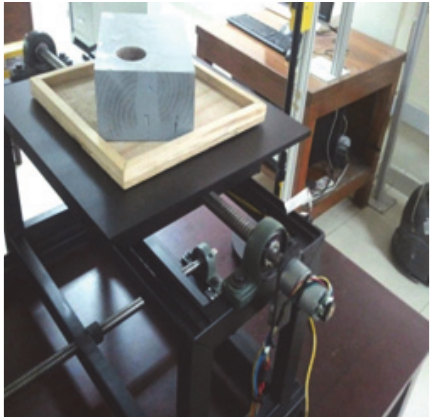
Figure 11: Mold and pallet on mechanical